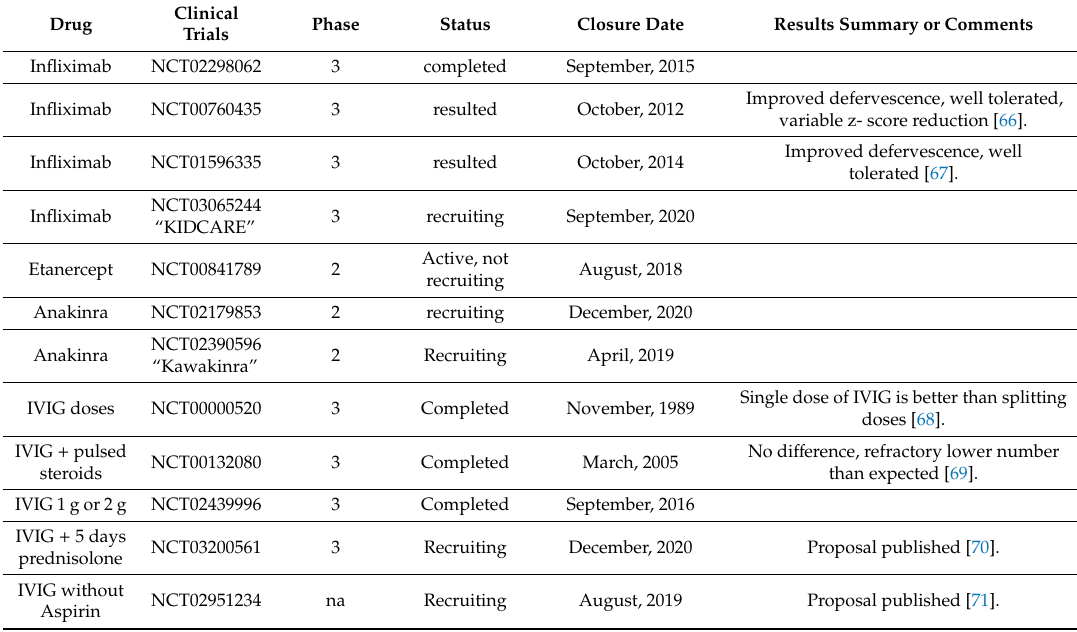
Table 1. Advanced clinical trials for treatments to prevent coronary aneurysms in Kawasaki Disease. Clinical Drug